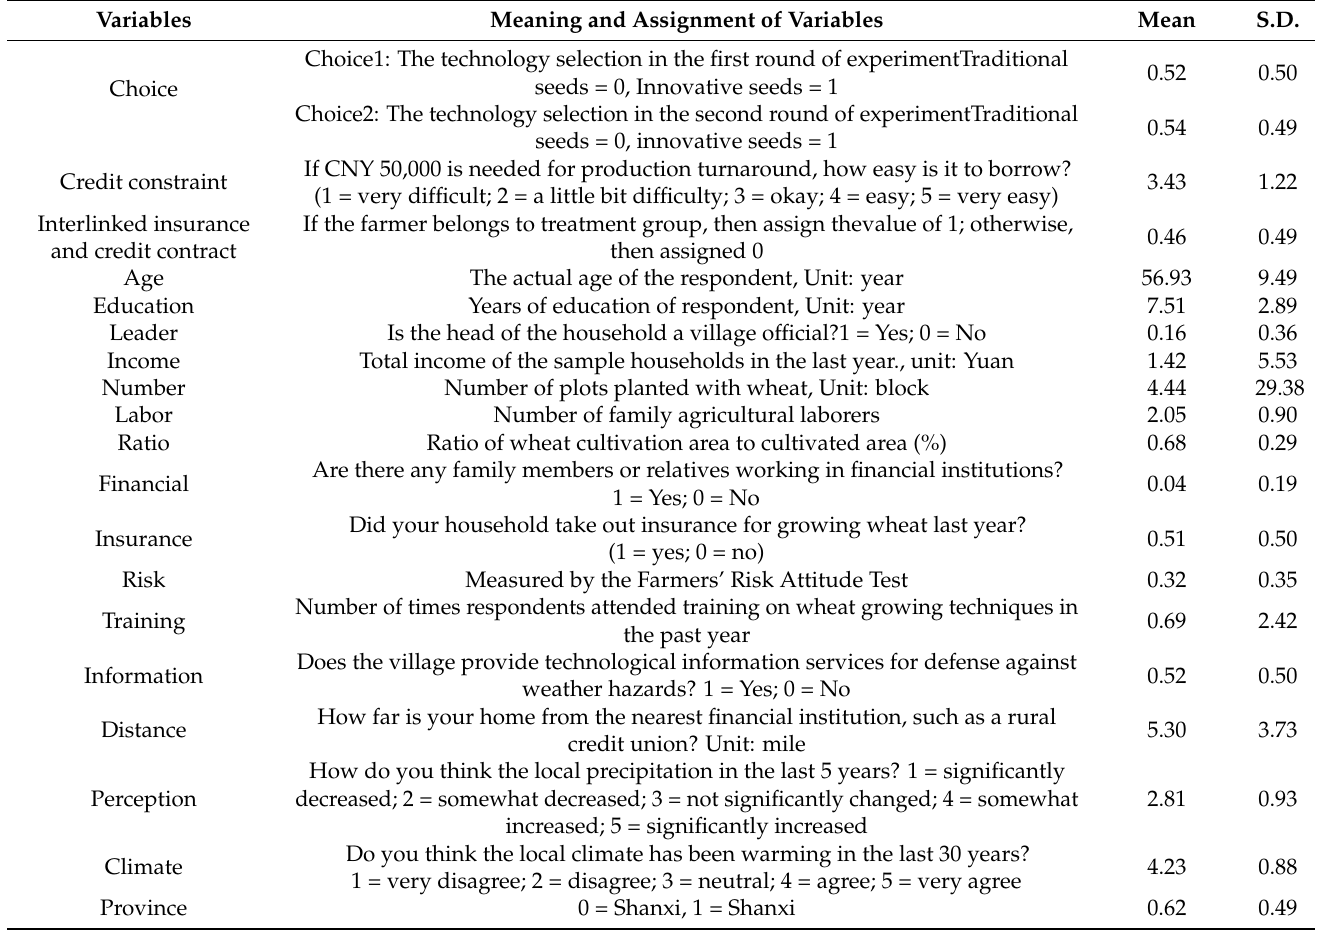
Table 5. Variable definition and descriptive